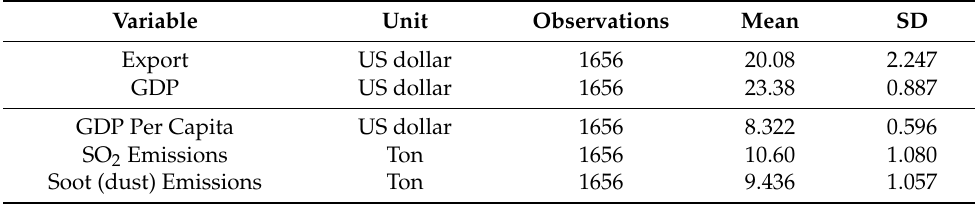
Table 1. Summary